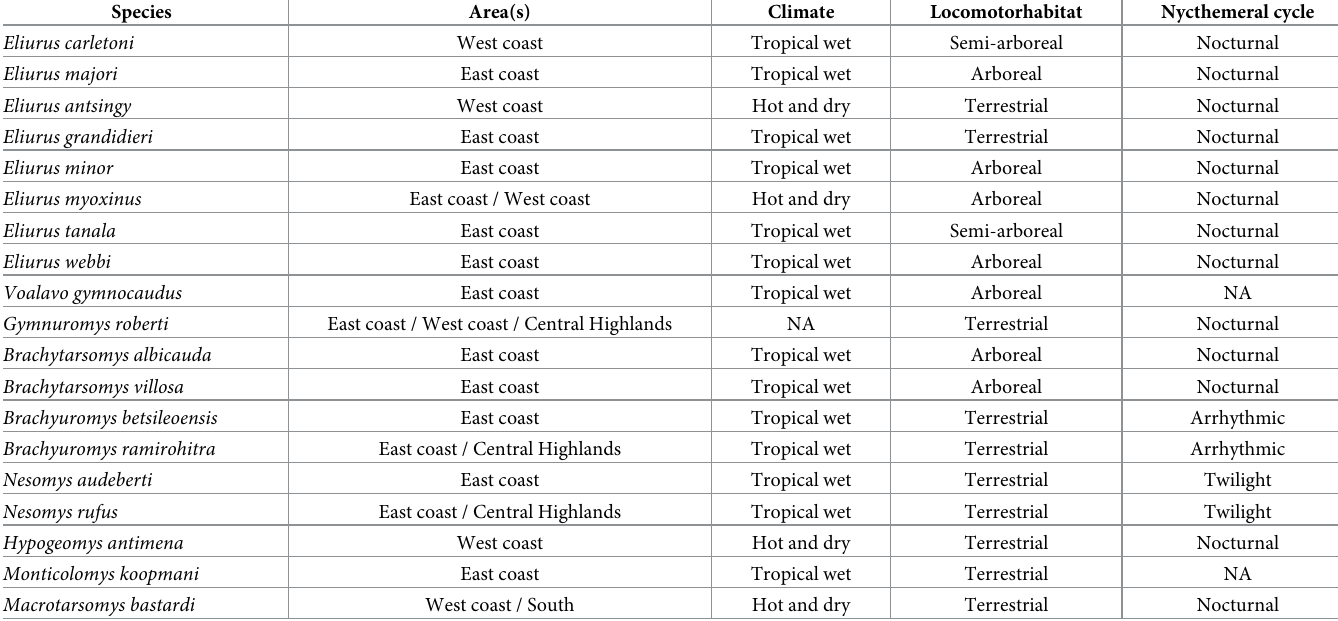
Table 2. Species and their associated ecological characteristics. Areas are generalized from collection localities, climate data are from the Direction Ge´ne´rale de la Me´te´orologie de Madagascar [44] and data concerning locomotor habits and nychthemeral cycle are from Goodman and Soarimalala (2011) [43].